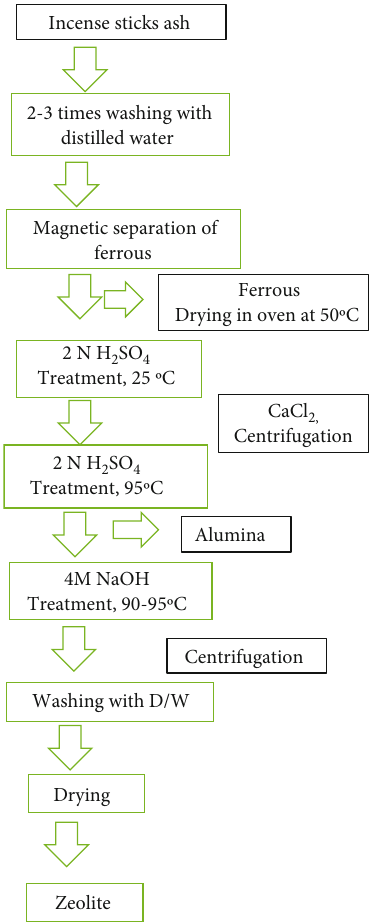
Figure 1: Schematic fl owchart for zeolite synthesis from